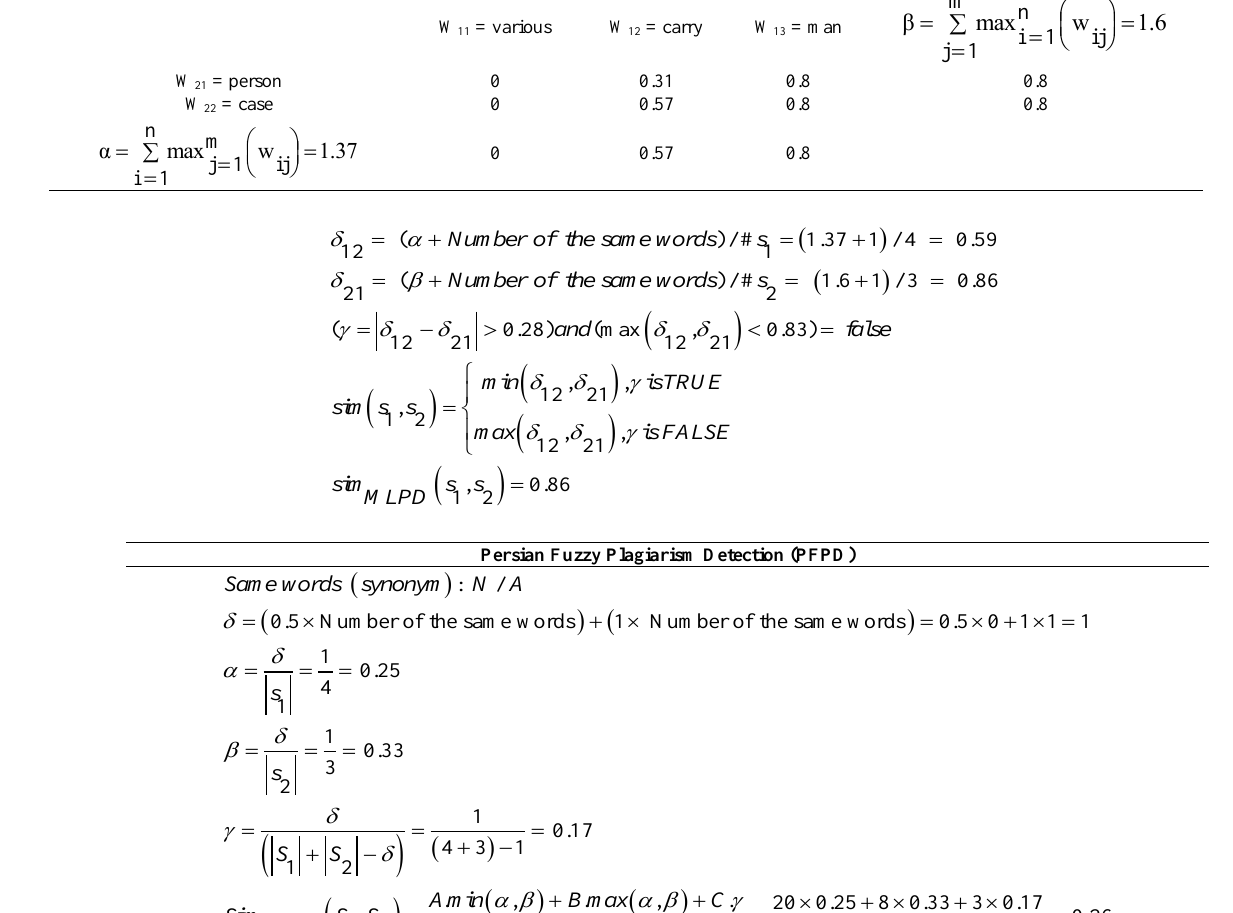
Figure 7. Case study